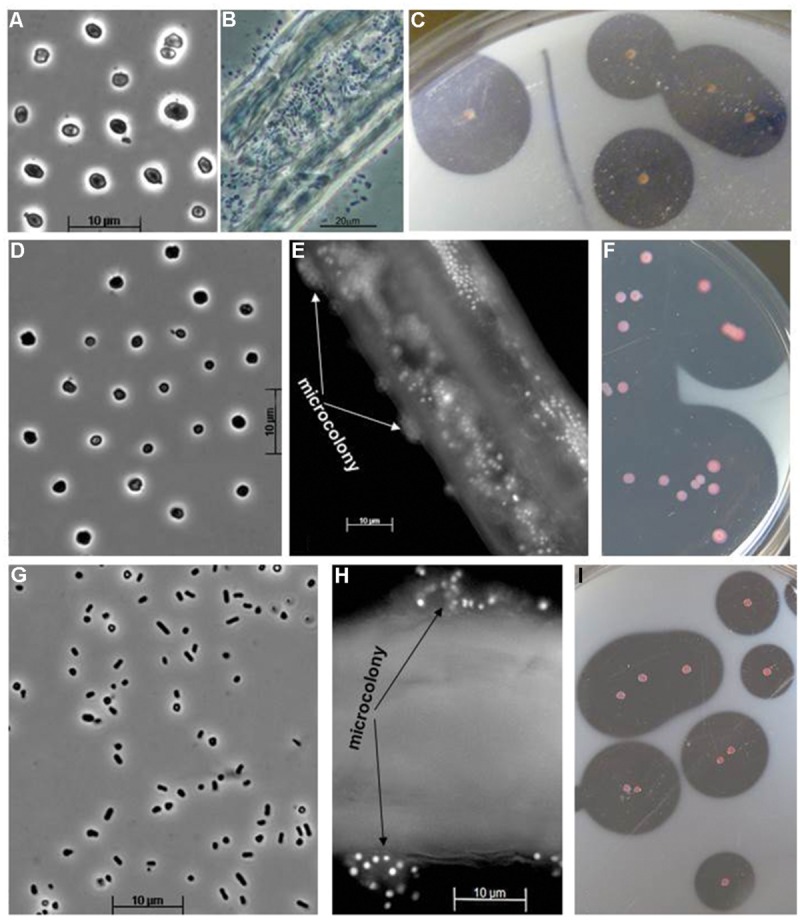
Cell and colony morphology of cellulotrophic haoarchaea grown at 4 M Na+, pH 7. (A–C), Strain HArcel1 [(A) free cells, (B) cells colonizing cellulose fibers, and (C) colonies on plates with amorphous chitin]; (D–F) Strain HArcel2 [(D) free cells, (E) microcolony formation on a cellulose fiber, fluorescent microscopy, and (F) colonies]; (G–I) strain HArcel3 [(G) free cells, (H) microcolony formation on a cellulose fiber, fluorescent microscopy, and (I) colonies].